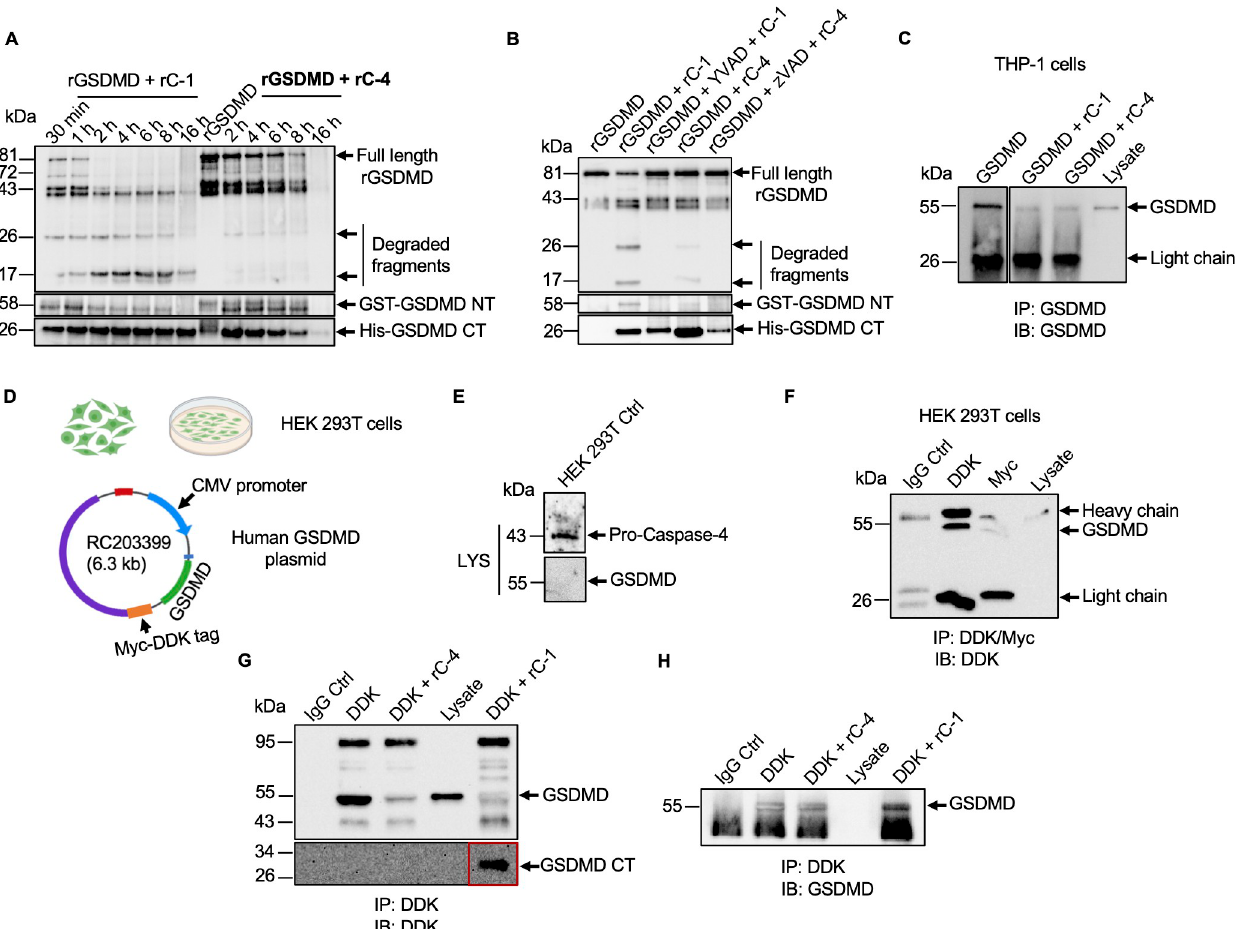
Fig 11. Full length gasdermin D is a proteolytic substrate for active caspase-4/1. ( A ) GST and His-tagged recombinant GSDMD (rGSDMD) was incubated with 1U recombinant caspase-1 (rC-1) and recombinant caspase-4 (rC-4) at 37˚C with indicated time points, following the detection by immunoblot analysis. ( B ) rGSDMD were incubated for 15 min at 37˚C with active rC-1 and rC-4 in absence or presence of inhibitor Z-VAD-fmk and Z-YVAD-fmk (100 μ M, 10 min, room temperature) and rGSDMD cleavage was assessed by western blot with anti-GSDMD, anti-GST and anti-His antibody. ( C ) Macrophages were immunoprecipitated with anti-GSDMD antibody and immunoprecipitants were incubated with active rC-1 and rC-4 for 16 h at 37˚C and GSDMD cleavage was assessed by western blotting identified with anti-GSDMD antibody. Direct cell lysate was used as a control (Ctrl). ( D ) C terminal Myc-DDk-tagged human GSDMD plasmid was overexpressed in HEK 293T cells and, ( E ) Basal expression of GSDMD was detected via anti- GSDMD antibody. ( F-H ) HEK 293T cells transfected with Myc-DDk-tagged GSDMD plasmid were immunoprecipitated with anti-DYKDDDDK tag antibody. Immunoprecipitants were incubated with active rC-4 and rC-1 for 16 h at 37˚C and GSDMD cleavage was assessed by western blot with anti- DYKDDDDK tag and anti-GSDMD antibody. Immunoblots are representative of at least three independent experiments (n = 3).